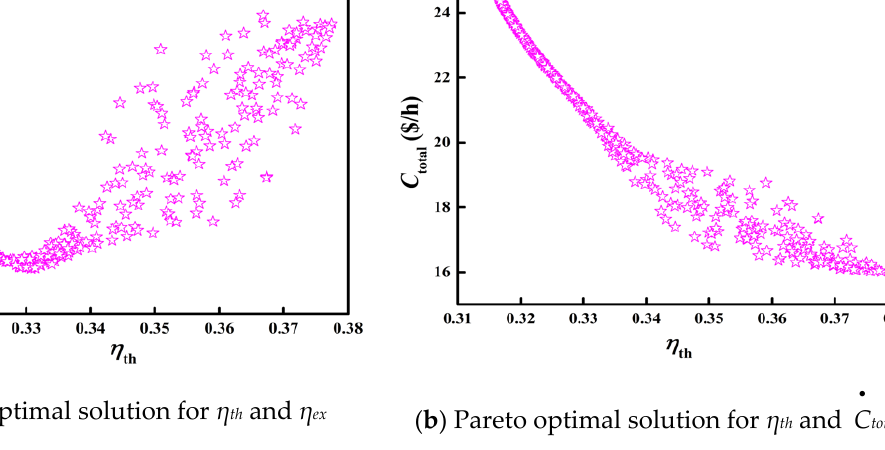
Table 7. Pareto optimal solution for η th , η ex , and